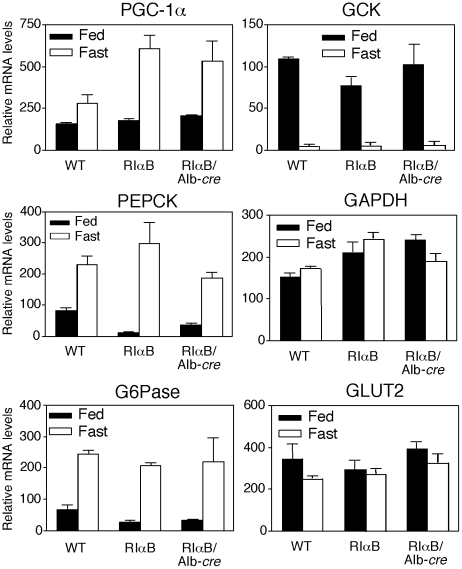
Liver-specific PKA inhibition does not alter fasting-regulated gene expression.mRNA levels of enzymes required for gluconeogenesis in the 24 hr fasted state (Fast) or after being fasted for 24 hr then allowed access to food for 6 hr (Fed) in WT, RIαB, and RIαB/Alb-cre mice. Levels of each mRNA were measured by quantitative real time PCR as described in Materials and Methods. Data are expressed relative to the results of a fasted WT control animal. Each value represents the mean ± SEM; n = 3 animals per group. No significant differences were found in gene induction. PGC-1α (peroxisome proliferator-activated receptor-γ coactivator 1α), PEPCK (phosphoenolpyruvate carboxykinase), G6Pase (glucose-6-phosphatase), GCK (glucokinase), GAPDH (glyceraldehyde 3-phosphate dehydrogenase), and GLUT2 (glucose transporter type 2).